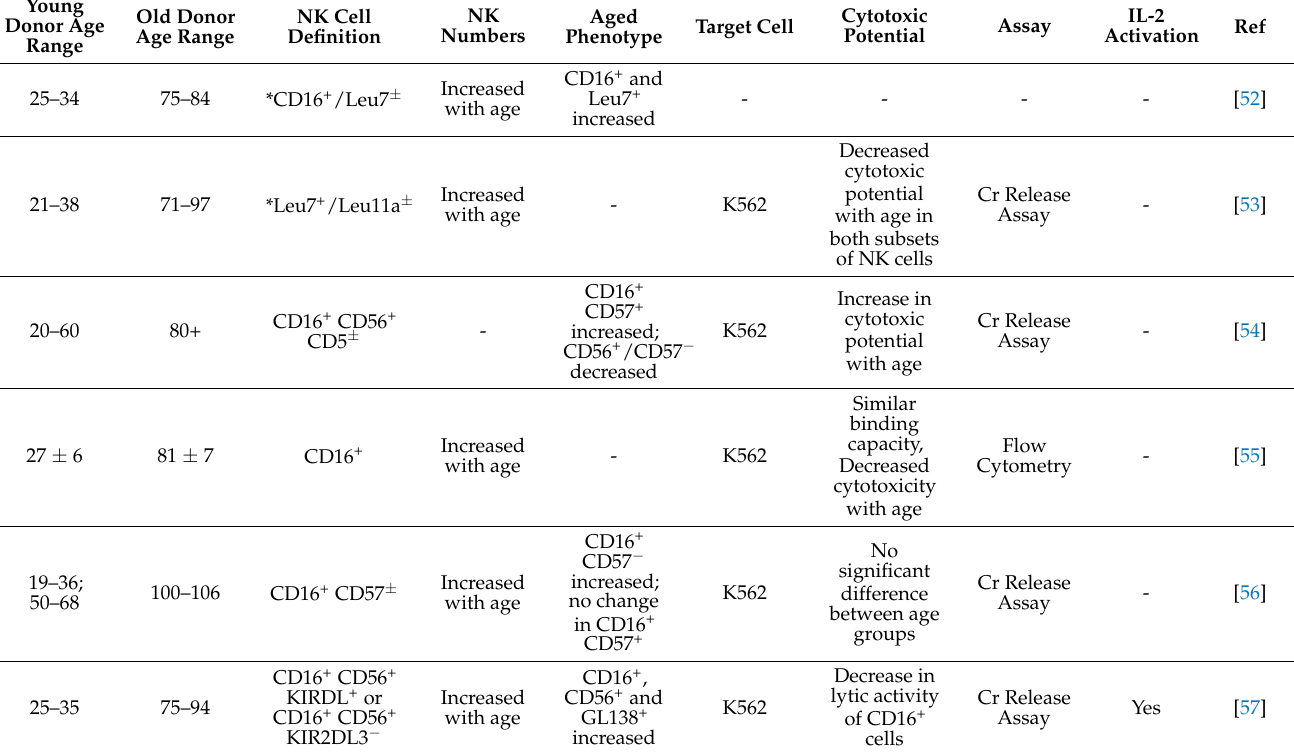
Table 1. Changes in natural killer cell phenotype, subset, and cytotoxicity throughout the aging process. Summary of age-related changes in natural killer cell phenotype, subset distribution, and cytotoxicity. Age-related changes in natural killer cell phenotype, subset distribution, and cytotoxicity against cancer cell